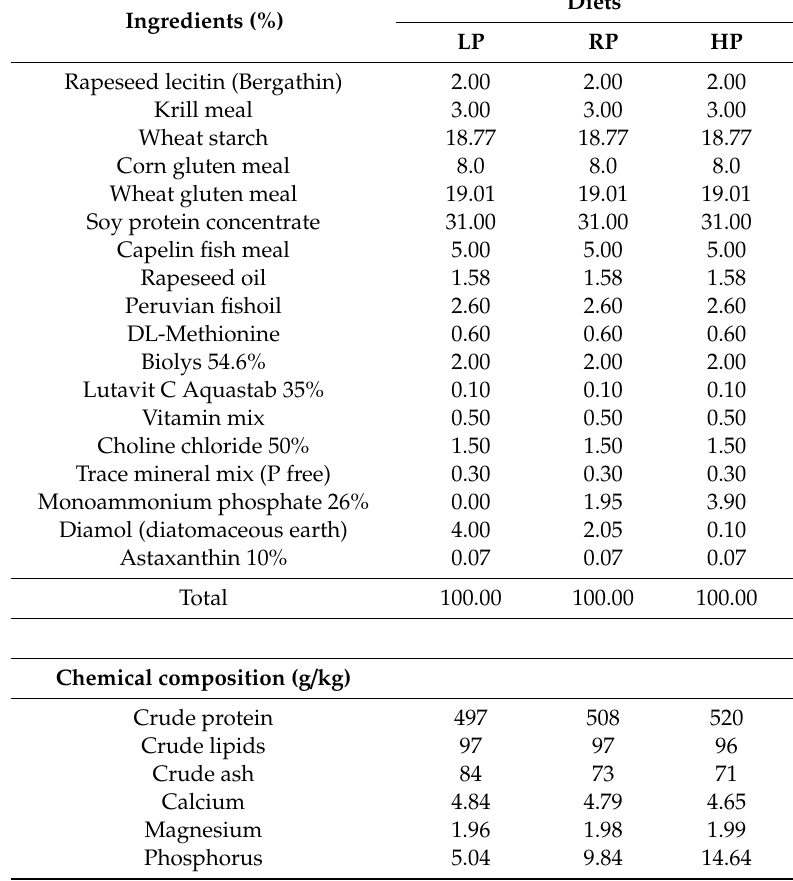
Table 3. Ingredients and chemical composition of the three experimental diets for